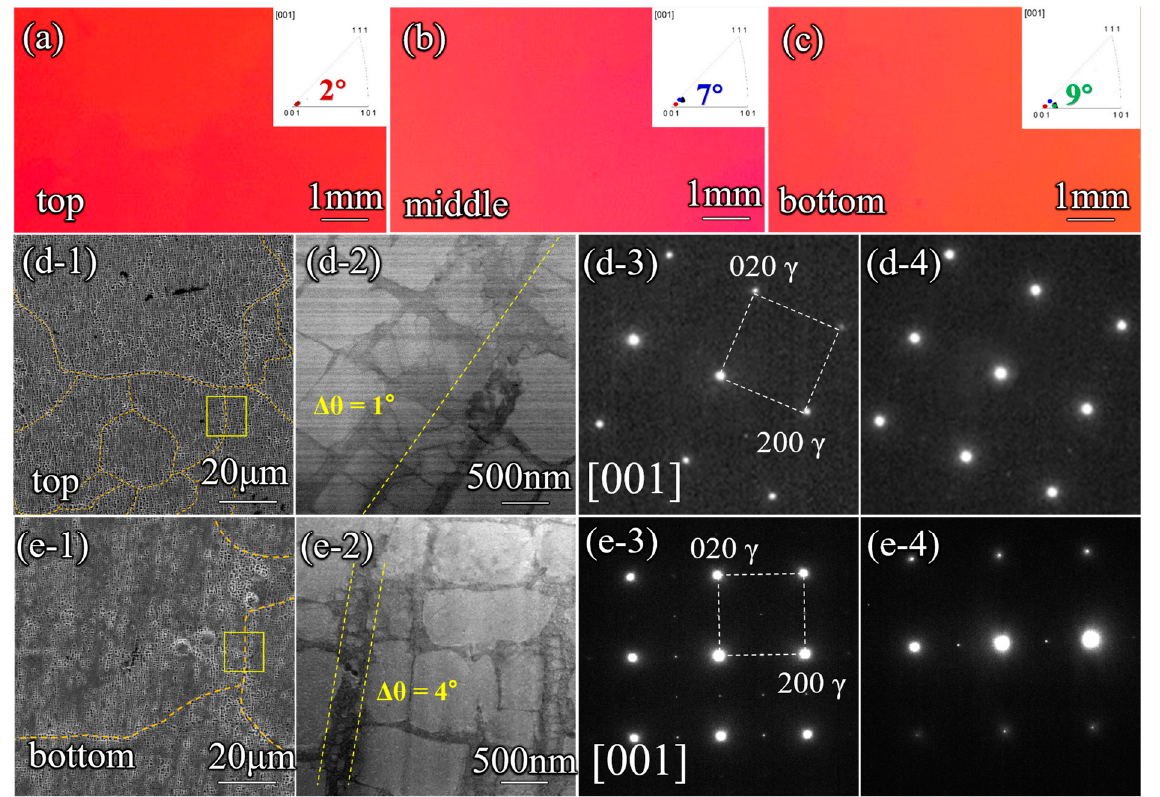
Figure 7. The distribution of orientation and grain boundary in the super-gravity treatment specimen. ( a – c ) EBSD patterns of the top, middle and bottom position in the super-gravity treatment specimen. ( d - 1 – d - 4 ) The grain boundary microstructure at the top of the specimen. ( e - 1 – e - 4 ) The grain boundary microstructure at the specimen’s bottom. In the figure, the orange curved outline the grain boundary, the yellow square boxes selected the characteristic position, and the yellow straight line marked the grain boundary at the characteristic position.